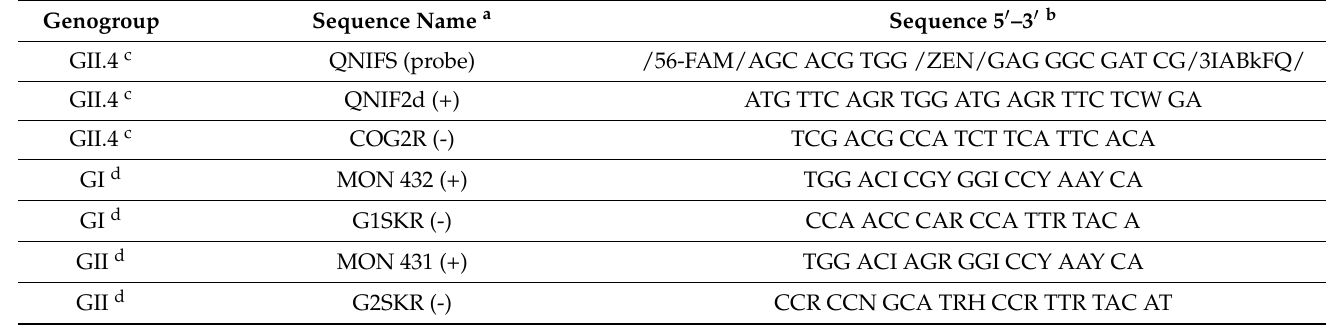
Table 1. Primers and probes used in this study. a , Parentheses indicate polarity; b , Y = C/T, R = A/G, I = deoxyinosine, N = A/C/T/G, H = A/C/T; c , Miura et al., (2013) [35]; d , Cannon et al., (2017)